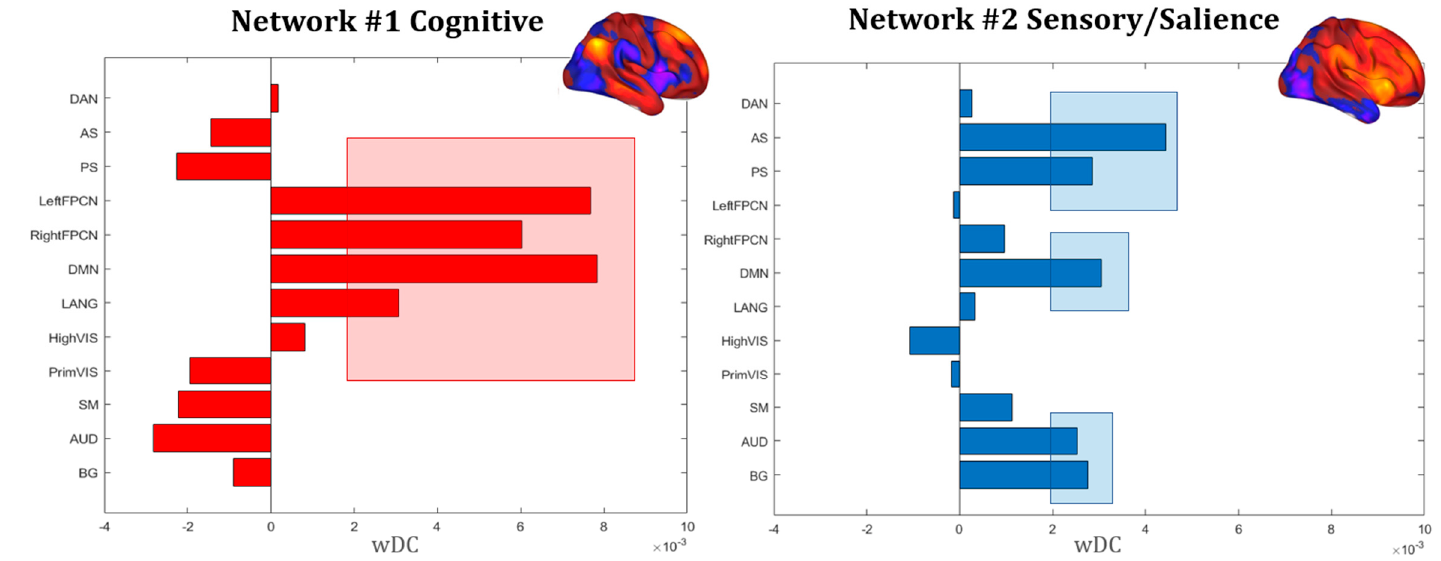
Figure 7. Similarity coefficient. Weighted DICE coefficients (wDC) for every RSN are shown, confirming the higher similarity between Network #1 and DMN, left and right FPCN and LANG, as well as the dissimilarity in connectivity profile with the AS, PS, auditory, visual and somatomotor networks. The opposite pattern was identified for Network #2, showing higher similarity for networks involved in sensory perception (AUD, SM, BG) and salience (AS, PS). Red and blue rectangles underline the higher significant overlap between the RSNs and DoC networks. Note: default mode network (DMN), right and left fronto-parietal control networks (right and left FPCN); dorsal attention network (DAN), anterior and posterior salience networks (AS, PS), basal ganglia network (BG); language network (LANG); high and primary visual networks (HighVIS, PrimVIS); precuneus network (Precuneus); auditory network (AUD); somatosensory network (SM).